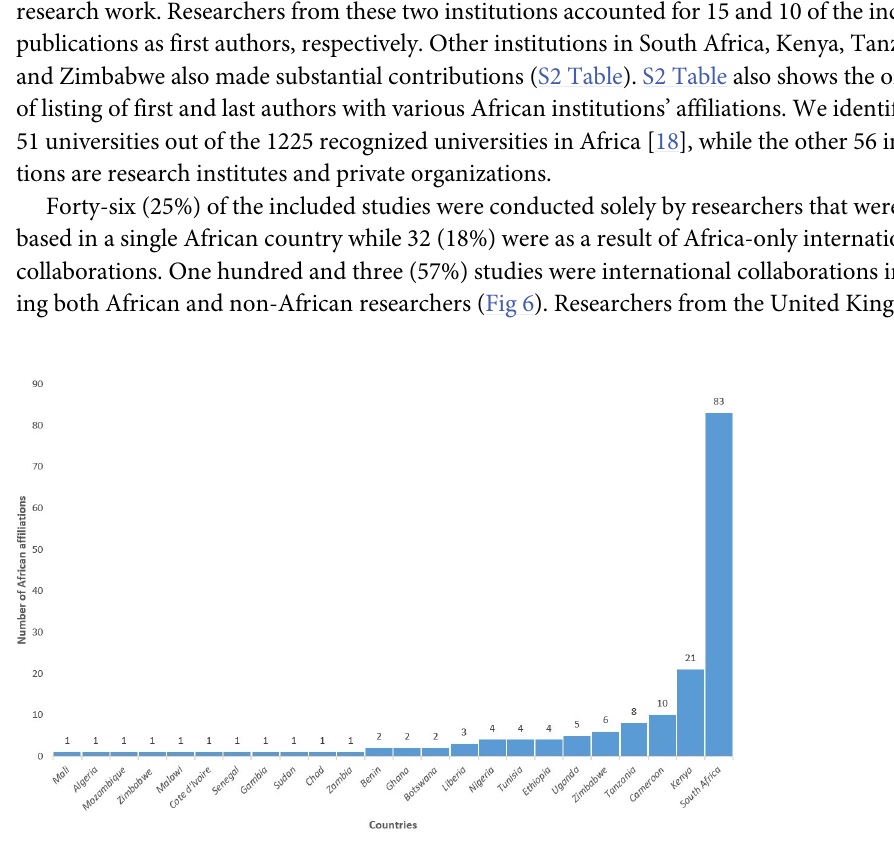
Fig 4. The number of publications with African institutional affiliated first authors by country of